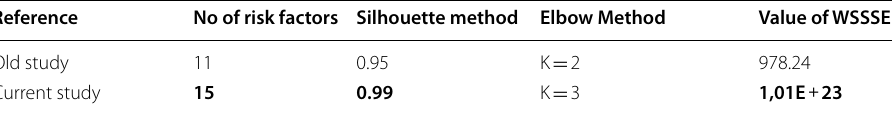
Table 11 Comparison with a previous